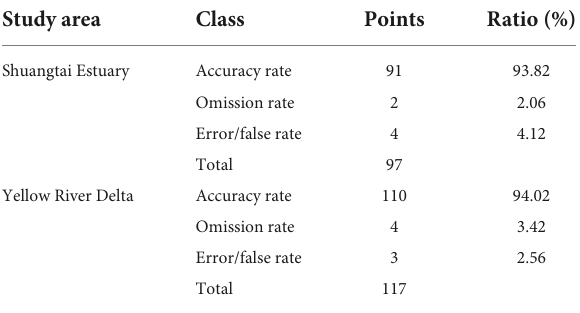
TABLE 4 The classification accuracy analysis based on DRM methods.